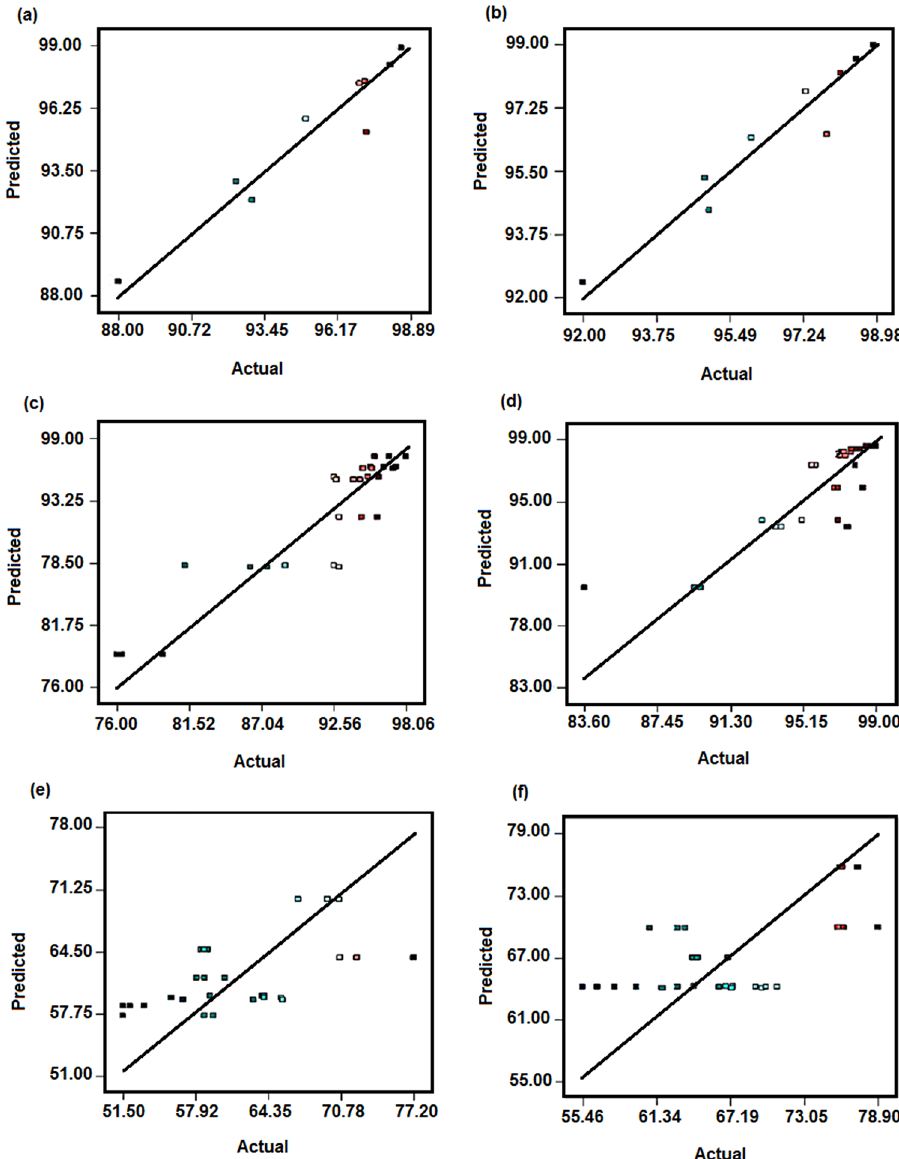
Figure 4. Response surface plot for COD and BOD 5 removal; anaerobic ( a , c ) aerobic ( b , d